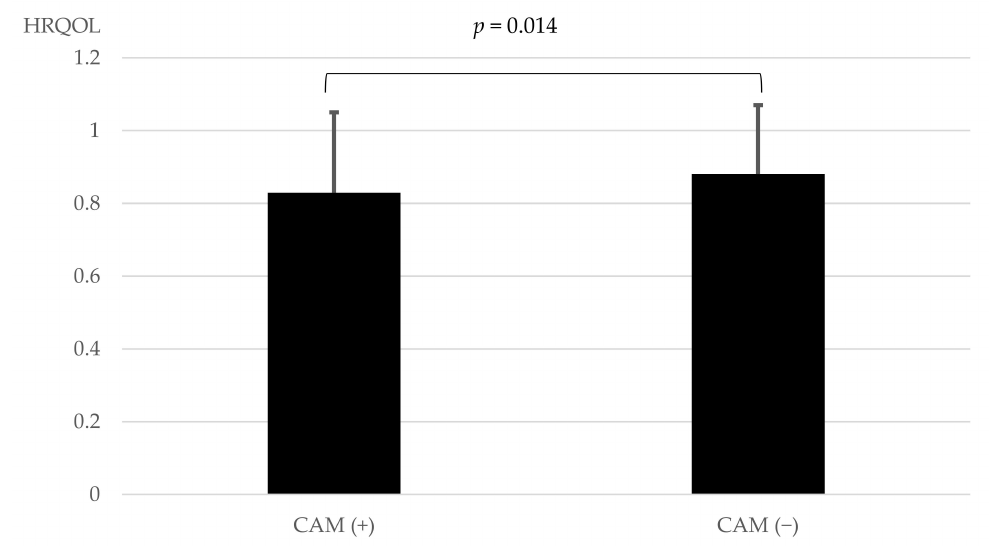
Figure 1. Comparison of HRQOL between patients with and without the use of CAM. Statistical analyses were performed using an analysis of covariance (ANCOVA) with adjustments for sex, age, BMI, the duration of diabetes, and HbA1c. HRQOL: health-related quality of life. CAM: complementary and alternative